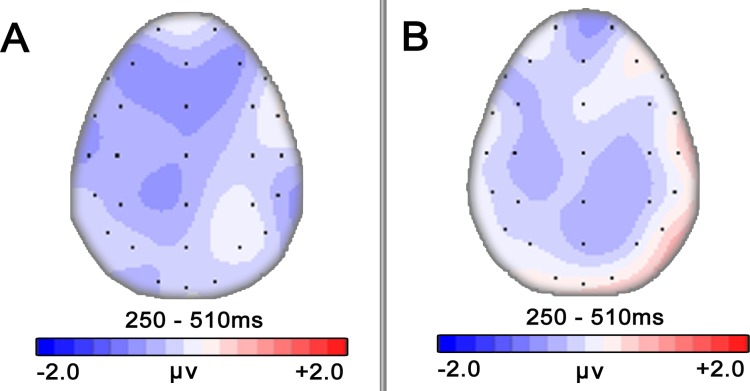
Difference-wave maps of N400(260ms~510ms) in Experiment 1 (A) and Experiment 2 (B).